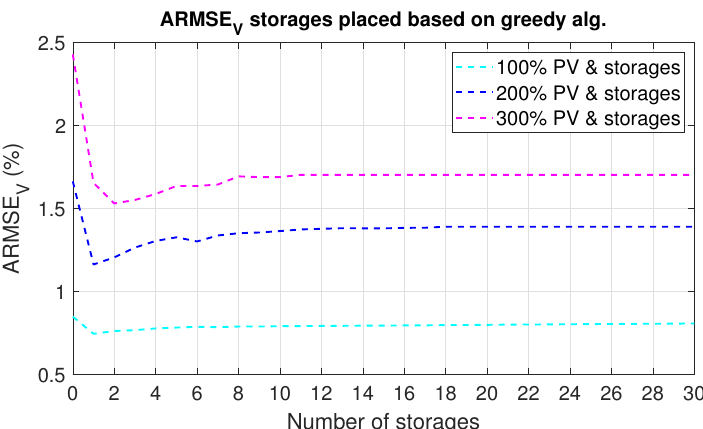
Figure 13. ARMSE of voltage across all buses and over a week for greedy-algorithm based storage deployment.